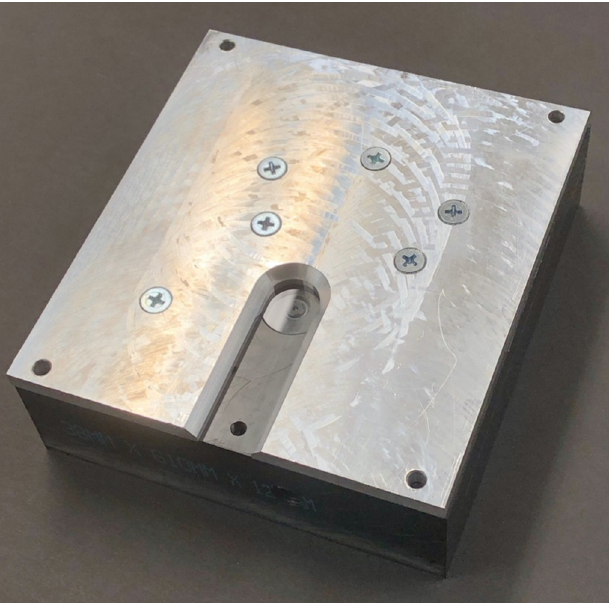
Figure 3. Camera-computer node housing design with integral dust cleaning air-knife.